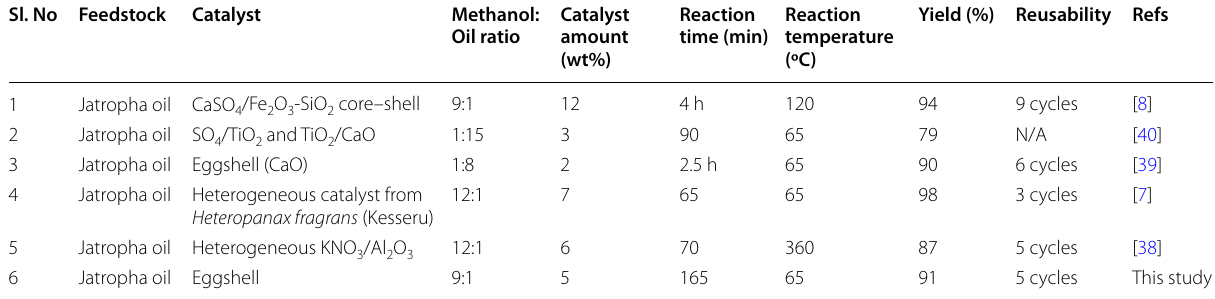
N/A Not available